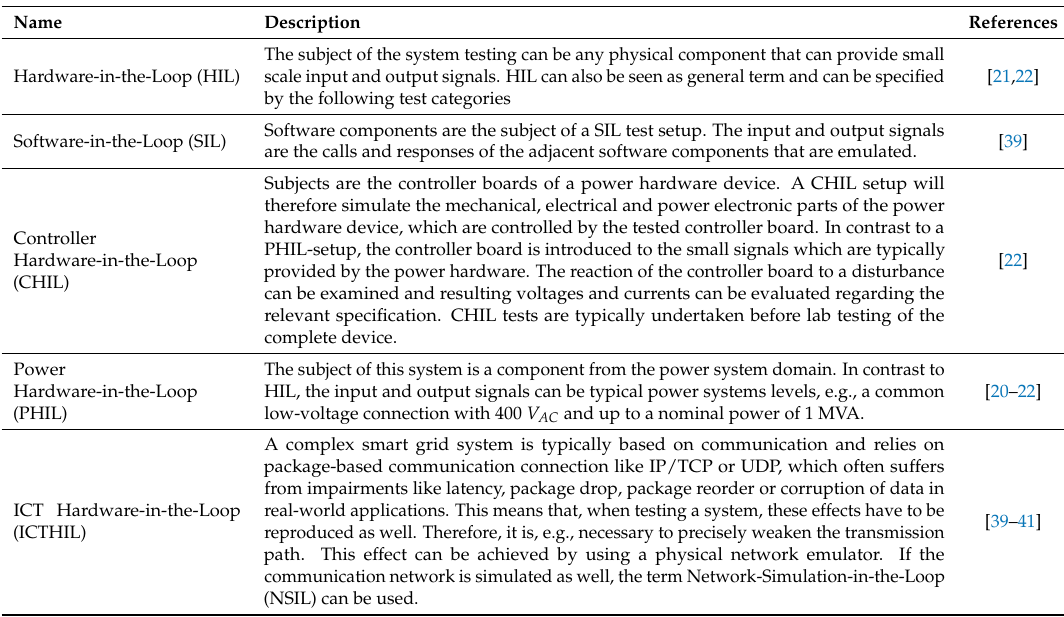
Table 2. Comparison of different domains using the X-in-the-loop concept for system testing with focus on the energy sector.